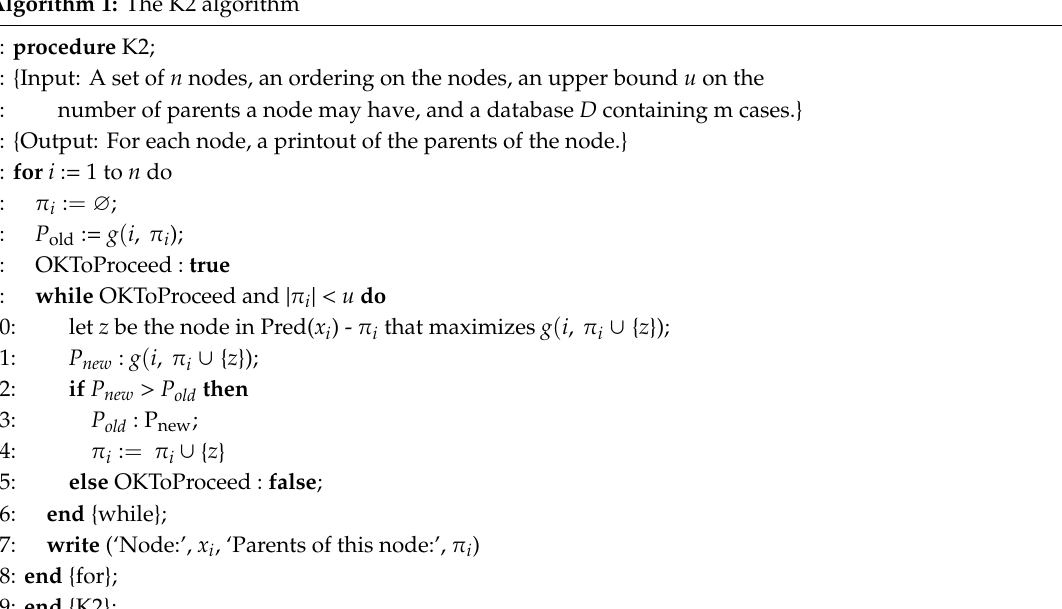
Algorithm 1: The K2